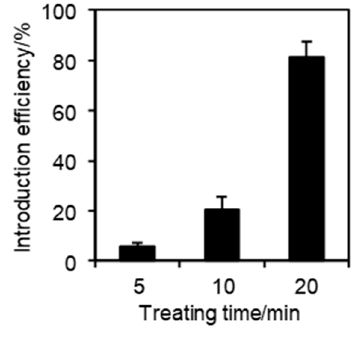
Figure 4. Effects of the incubation time on the incorporation efficiency. The HeLa cells were treated with NANOGEL- 6 (0.05 w/v%) in 5 % glucose solution at 25 °C for the indicated durations. The vertical bars represent the s.d. evaluated by at least four independent experiments.